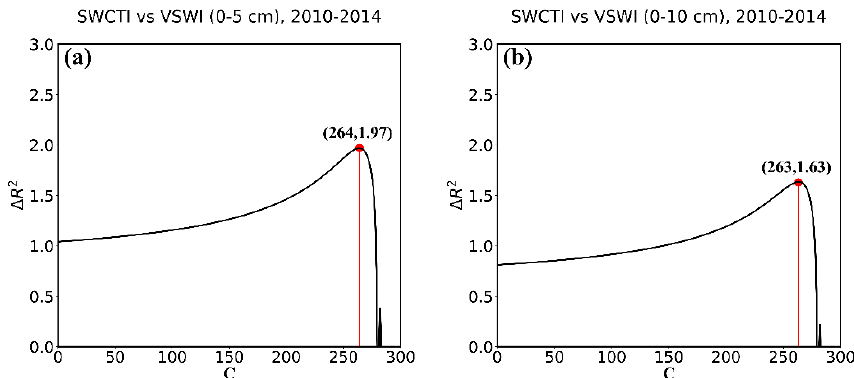
Figure 9. Curves of ∆R (cid:2870) with respect to the variable C at ( a ) 0–5 cm soil depth and ( b ) 0–10 cm soil depth.